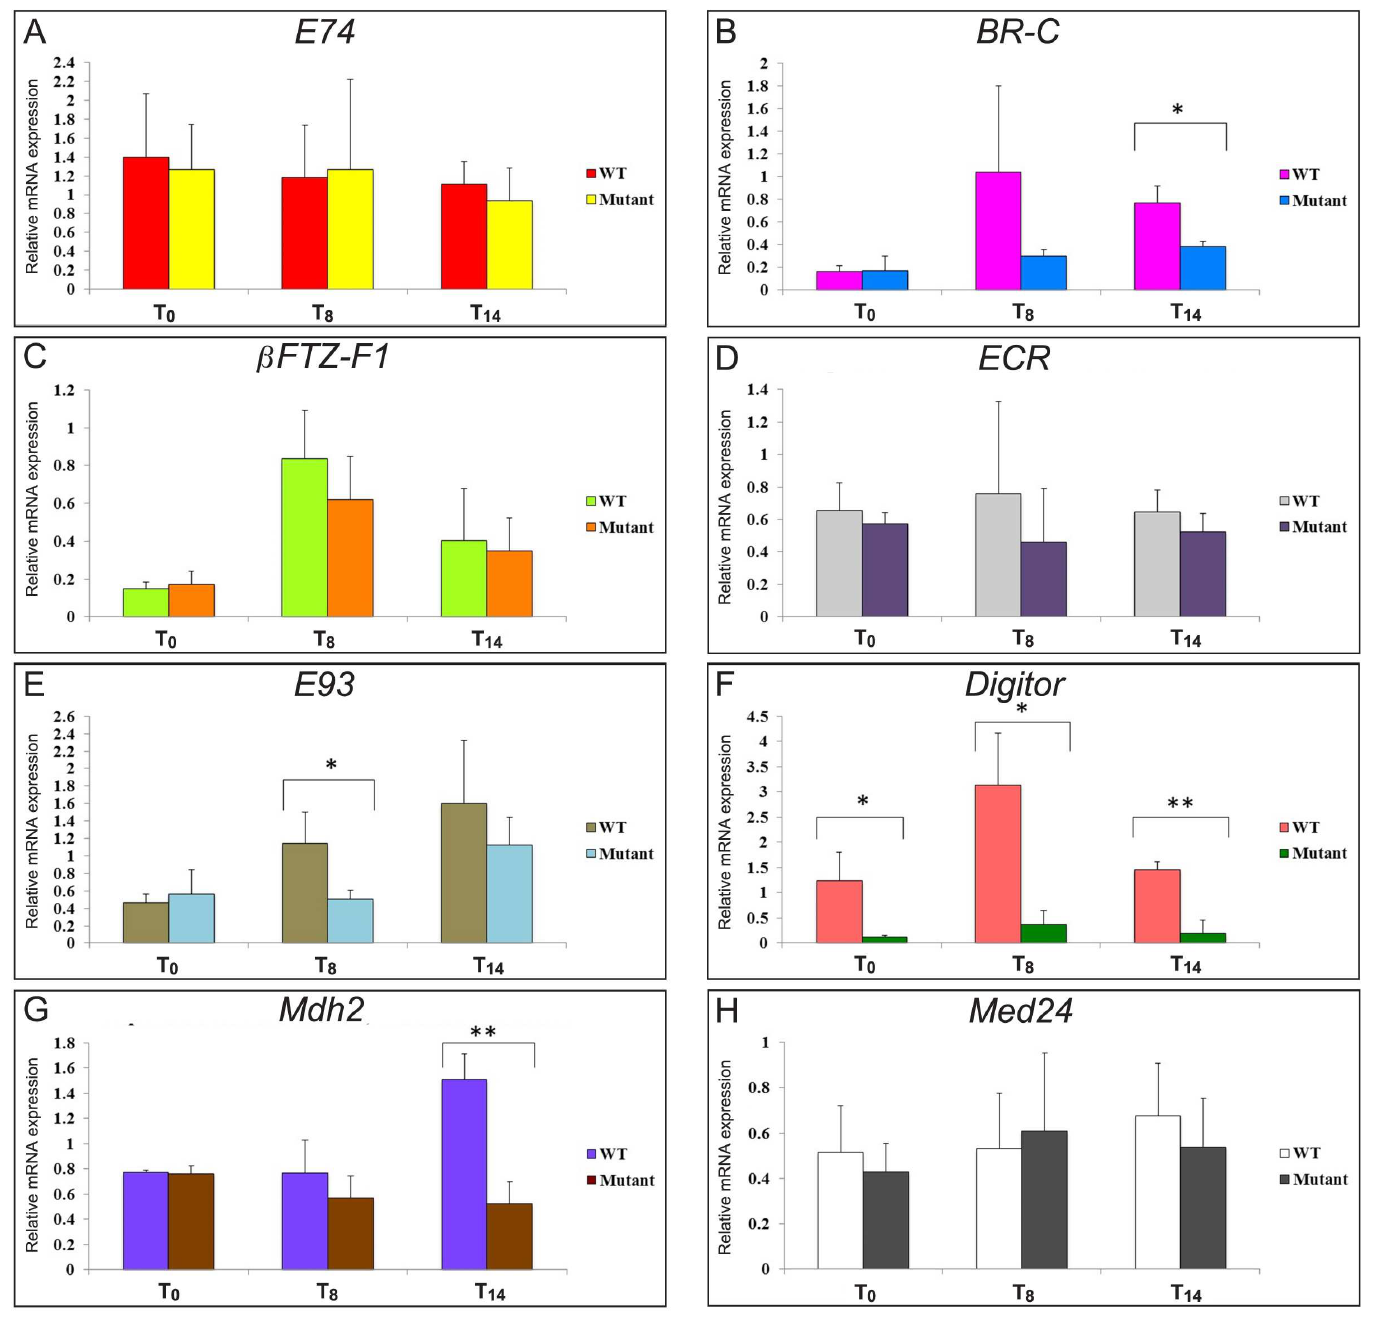
Fig 10. Comparison of mRNA expression of ecdysone-regulated and other genes relevant for morphogenesis in wild type and Digitor mutant prepupae and pupae. Relativelevels of E74 (A), BR-C (B), β FTZ-F1 ( C), ECR (D), E93 (E), Digitor (F), Mdh2 (G), and Med24 (H) mRNA expressionwere determined at the white prepupaestage (T 0 ), mid-prepupal stage (T 8 ), and just after head eversion (T 14 ) and normalized to RP49 expressionlevels. Each bar representsthe averageof three independent replicateswith S.D. Statistically significantexpressiondifferences were determinedusing a Student’s two-tailed t-test ( * , P < 0.05; ** , P <